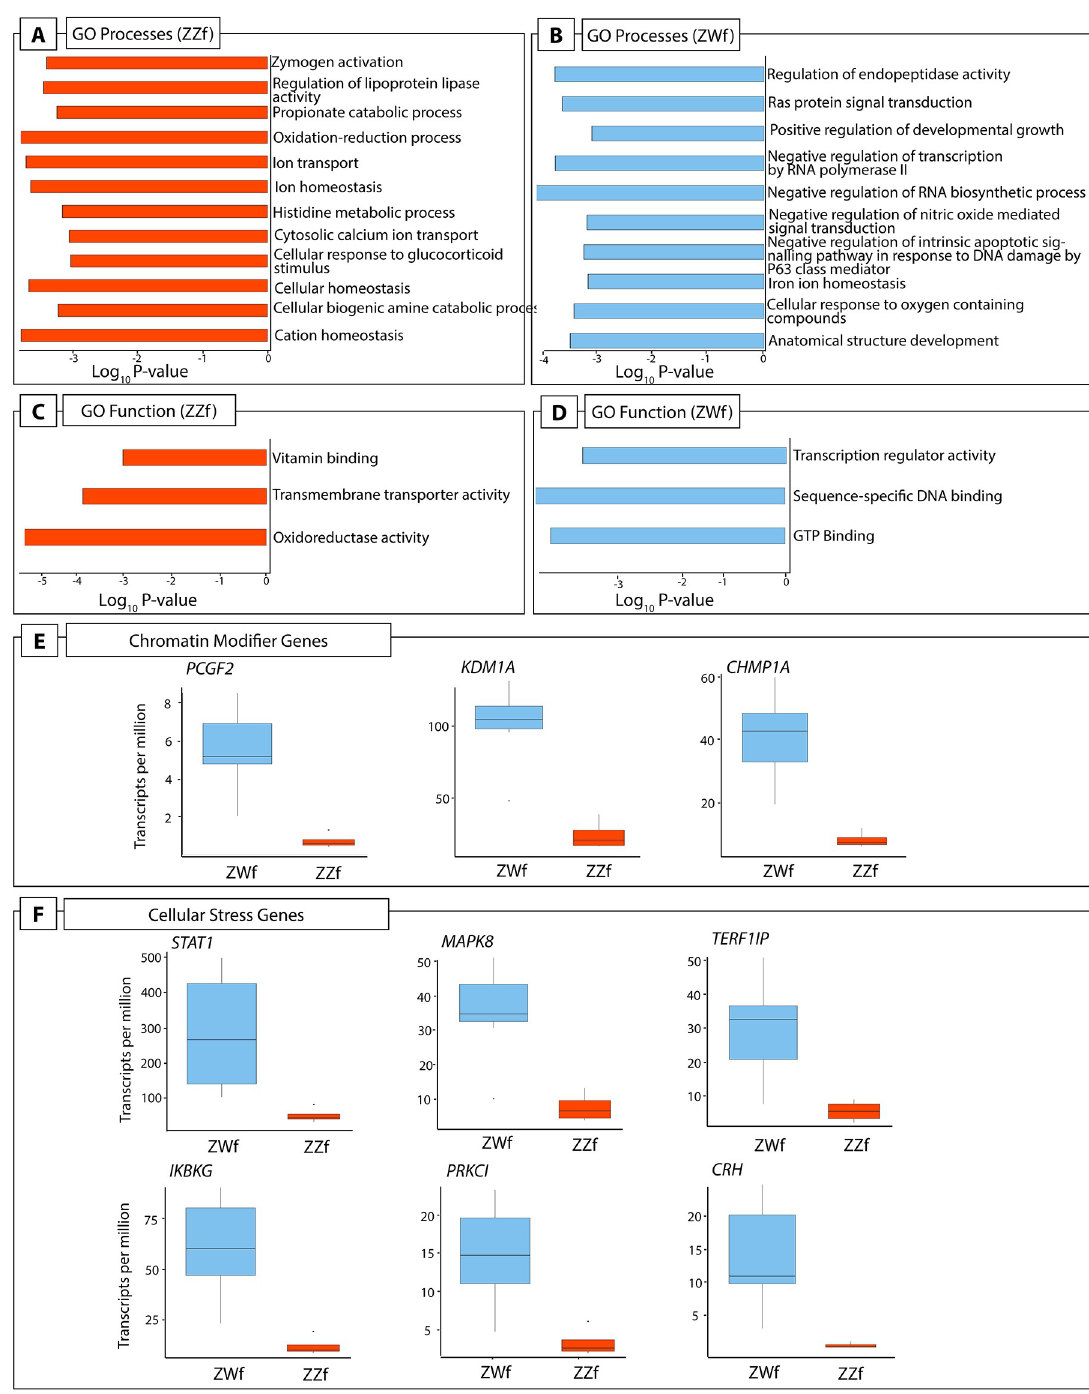
Fig 5. ( A ) A subset of GO processes and ( C ) GO functions enriched in stage 6 ZZf embryos compared with ZWf. ( B ) A subset of GO processes and ( D ) GO functions enriched in stage 6 ZWf embryos compared with ZZf. Complete results of GO analysis for all developmental stages in ZZf and ZWf for enriched GO processes and functions is provided in S2 Data. Differentially expressed chromatin modifier ( E ) and cellular stress ( F ) genes in Pogona vitticeps at stage 6 comparing ZWf and ZZf females.